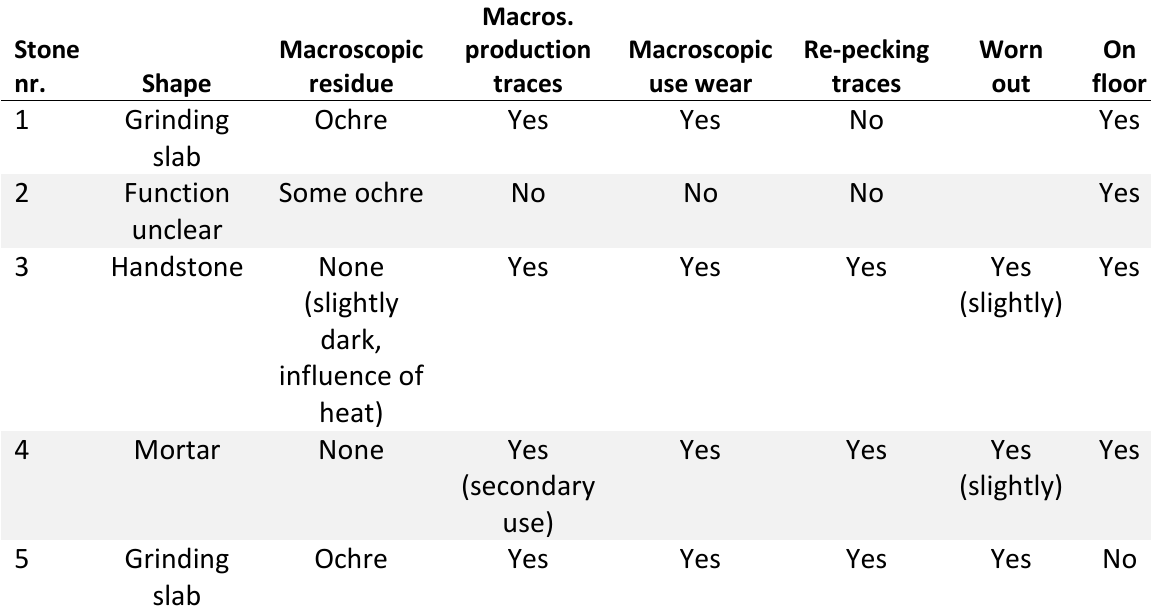
Macros. production traces